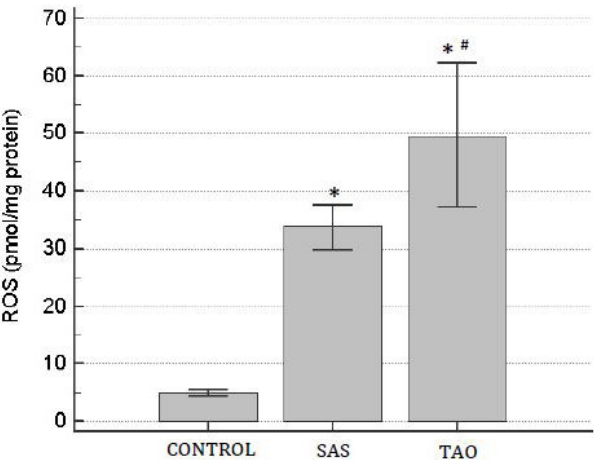
Fig. 1 - Levels of reactive oxygen species (ROS) on human aortas of patients with severe aortoiliac occlusive stenosis (SAS) and with total aortoiliac occlusion (TAO). Values are expressed in mean and the brackets represent interval of confidence of 95%. ANOVA followed test t. *P<0.05 when compared to control group; and # P<0.05 when compared to SAS